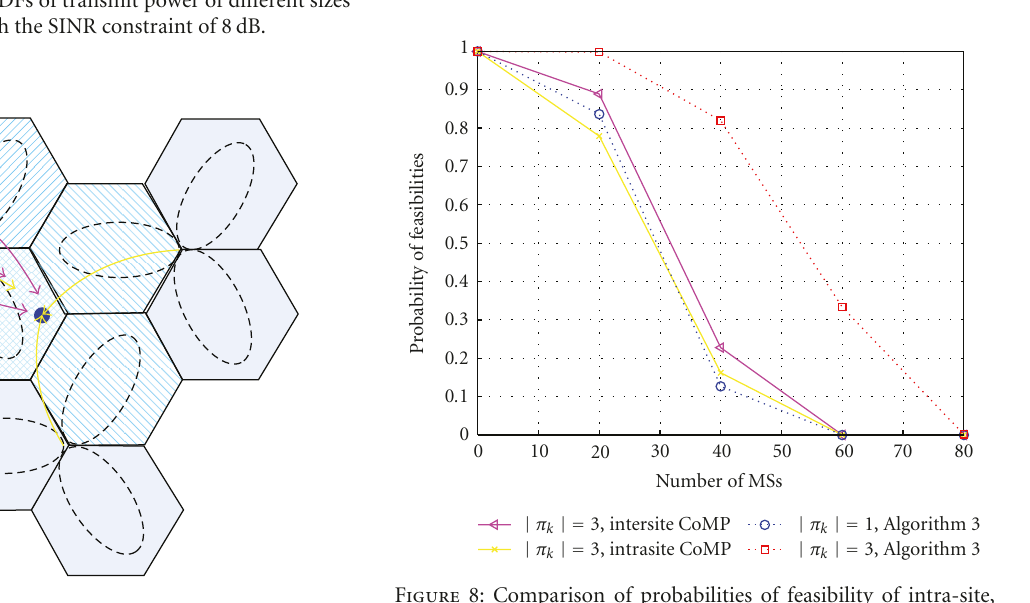
Intercell coop. Intracell coop. Figure 6: An illustration of inter-site and intrasite reception schemes.